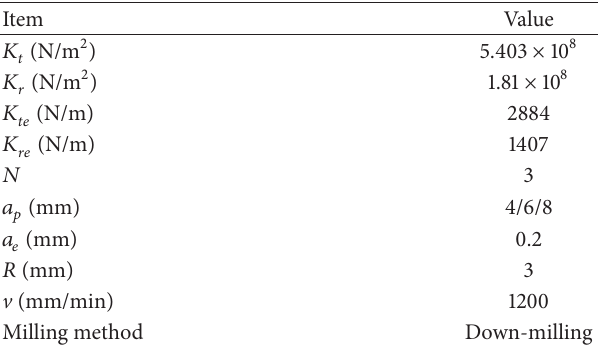
Table 2: Parameters of milling process.